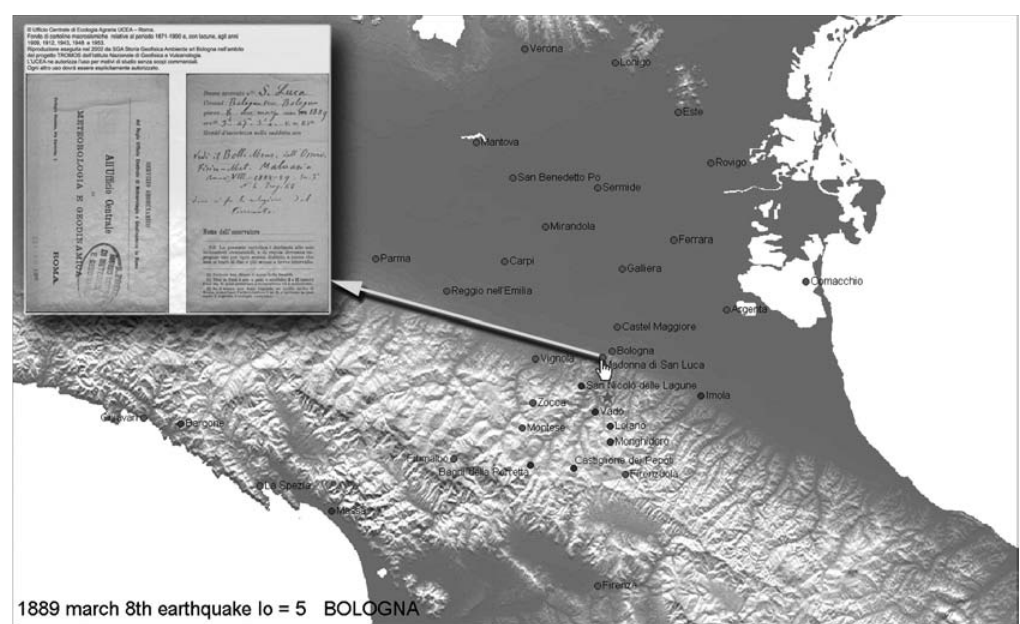
Fig. 21. Example of interactive map allowing to geographically access the consultation of the digital file of the macroseismic questionnaires. By clicking on the map the documents relating to each location can be visualised and